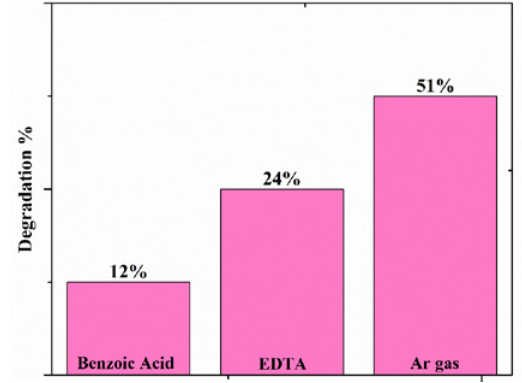
Fig. 8. A series of trapping experiments (a) Benzoic Acid, (b) Fig. 8 EDTA and (c) Ar gas for the degradation of AO7 over Ag- TiO G photocatalysts under UV light irradiation. 2-